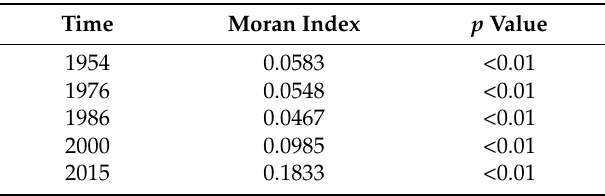
Table 4. Global Moran’s I for paddy fields at different